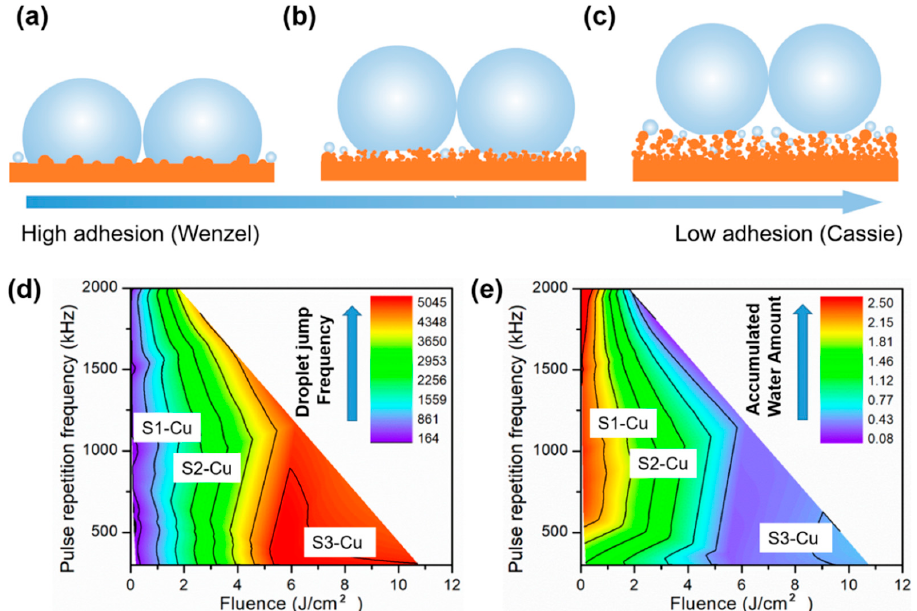
Figure 3. Effects of laser processing parameters on surface morphology and wetting properties of condensed droplets. ( a ) Schematic showing Wenzel droplets coalescing with no occurrences of jumping. ( b ) Schematic showing coalescence of partial-wetting droplets; inefficient droplet jumping results from a lack of surface nanostructure, roughness, and structural height. ( c ) Schematic showing the coalescence of CB droplets, which leads to efficient droplet jumping. ( d ) Phase map relating laser processing parameters to the number of droplet jumping events for Cu. The red and purple regions represent the most frequent and least frequent (or nonjumping) events, respectively. ( e ) Phase map relating laser processing parameters to the amount of accumulated water for Cu. The red and purple regions represent the highest and lowest amounts of accumulated water, respectively. Unit for the number of jumped droplets: min − 1 · cm − 2 ; unit for accumulated water over 30 min of the condensation experiment: mg/cm 2